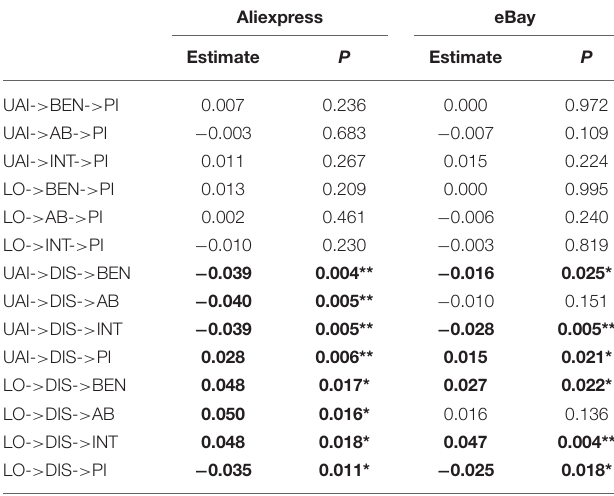
TABLE 6 | Mediating